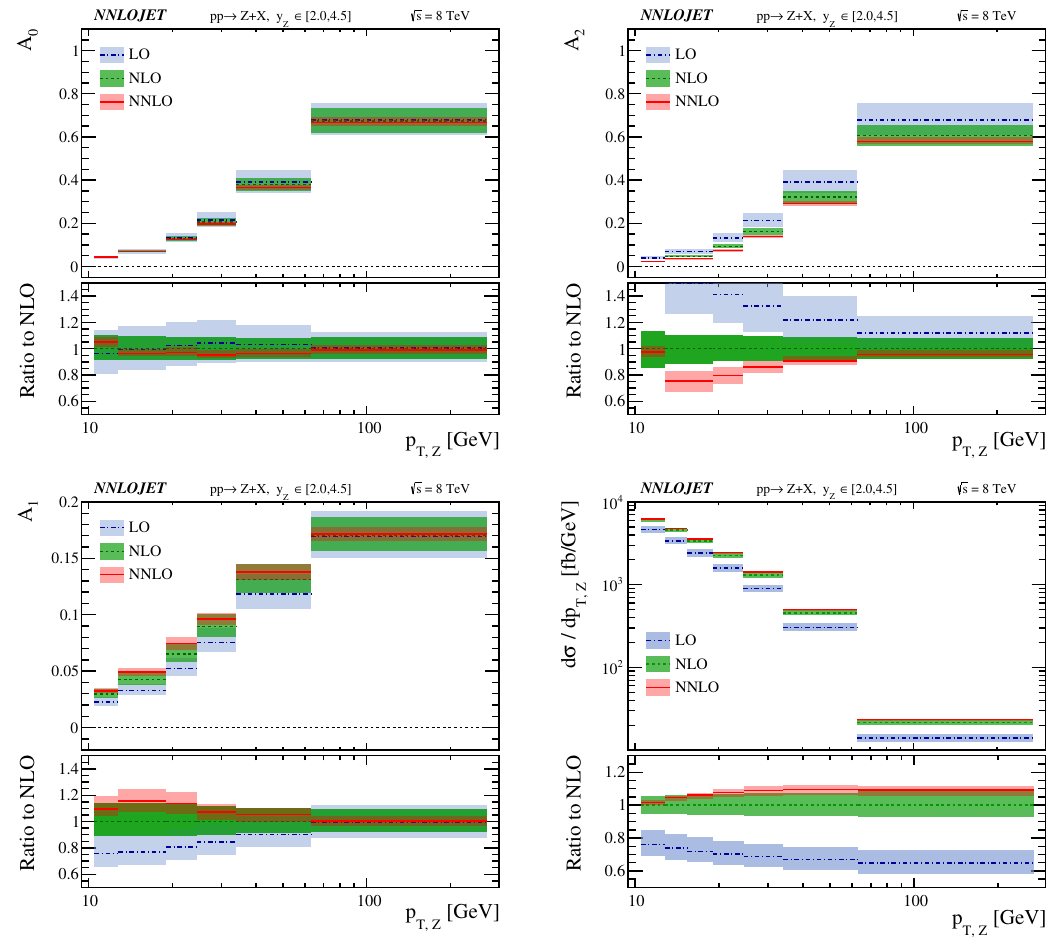
Figure 9 . The p T ; Z distribution for the angular coe(cid:14)cients A 0 (upper left), A 2 (upper right), A 1 (lower left), as well as the unpolarised cross section (lower right) in pp collisions at A kinematic cut of y Z 2 [2 : 0 ; 4 : 5] (corresponding to the LHCb (cid:12)ducial region) is required for all distributions. Theoretical predictions are provided at LO (blue (cid:12)ll), NLO (green (cid:12)ll), and NNLO (red (cid:12)ll) accuracy. In the lower panel, each distribution is shown normalised with respect to the central NLO